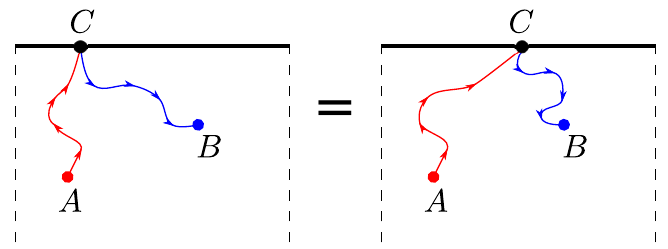
Figure 2 . Path independent holonomy. The red curve corresponds to the holonomy of A ( λ ) between A and C . The blue curve corresponds to the holonomy of A β ( − λ ) between C and B . =